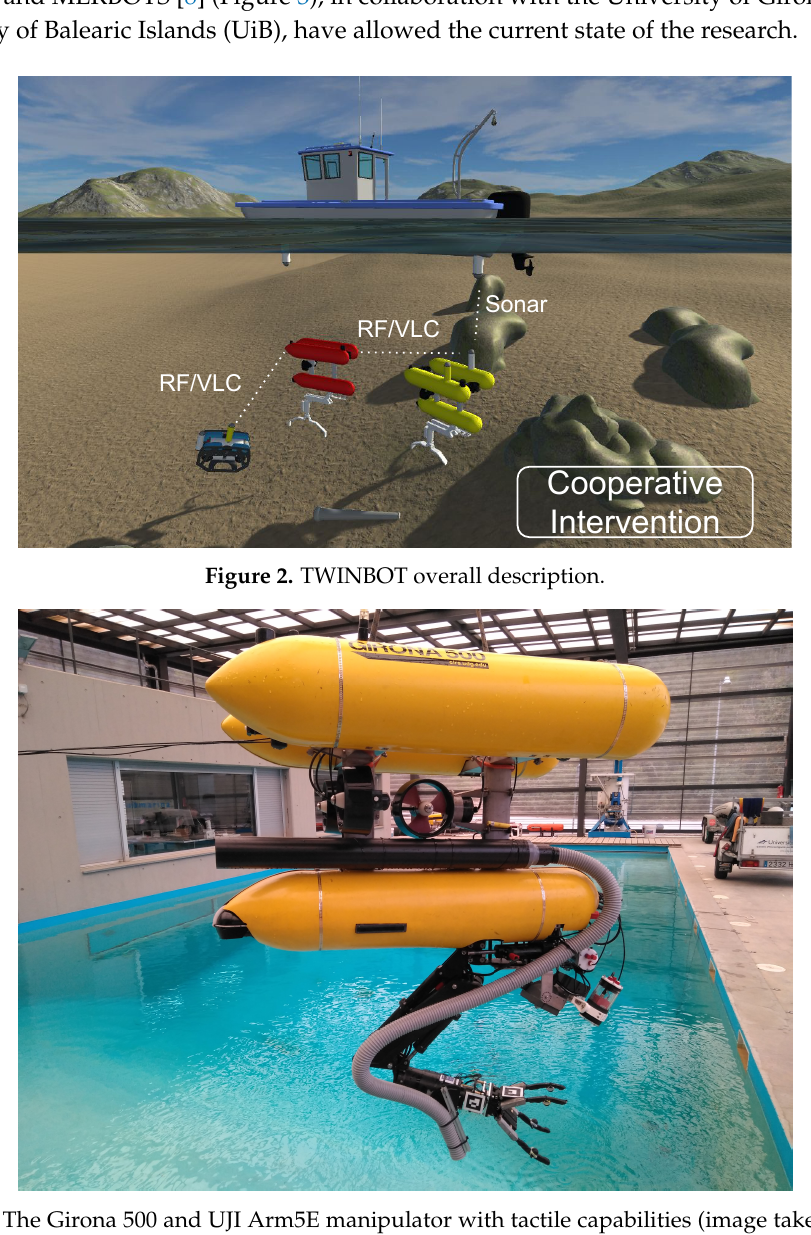
Figure 3. The Girona 500 and UJI Arm5E manipulator with tactile capabilities (image taken